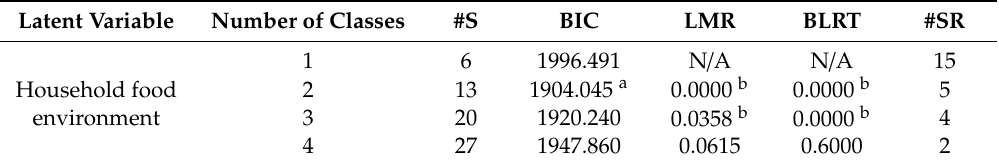
Table 1. Model fit indicators for 1-, 2-, 3-, and 4-class models using data from three Native American communities ( n = 300) from the Midwest and Southwest, 2016–2017